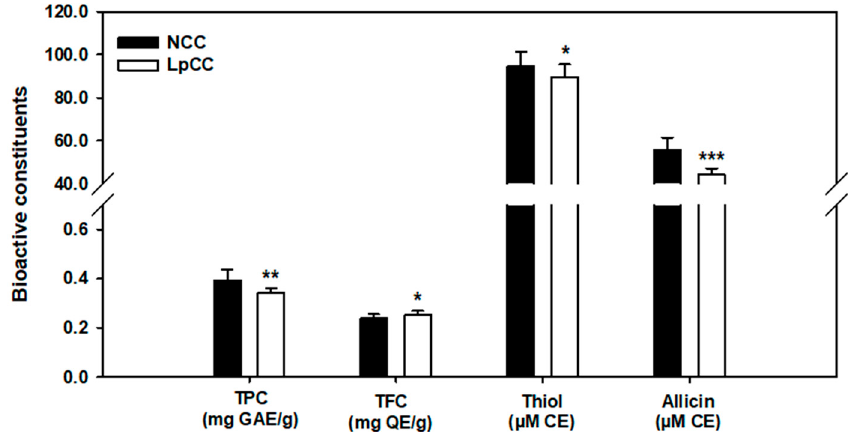
Figure 3. Changes in the biochemical constituents of CC juice following L. plantarum fermentation. TPC: total phenolic content expressed in mg of gallic acid equivalent (GAE) per gram of extract; TFC: total flavonoid content expressed in mg of quercetin equivalent (QE) per gram of extract; thiol and allicin are expressed as micromolar of cysteine equivalent (CE). (* p < 0.05, ** p < 0.01, *** p < 0.001), Statistically significant compared with the NCC.